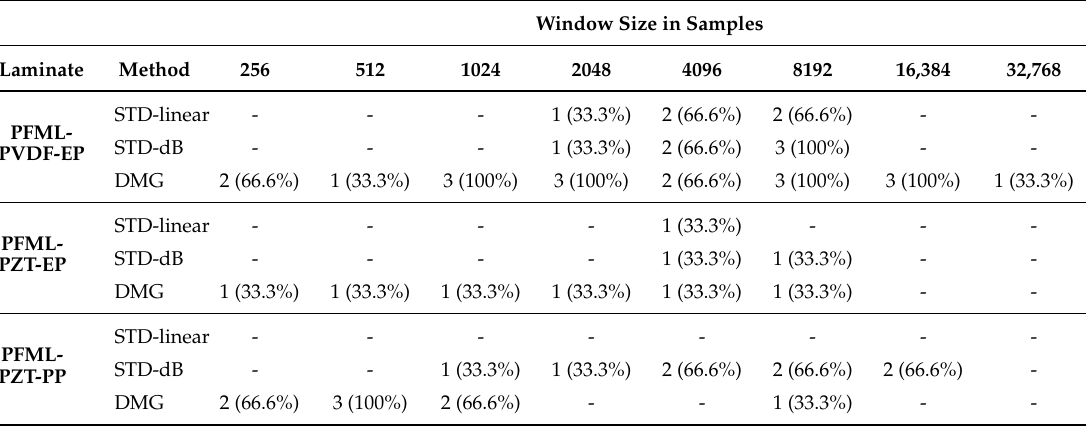
Table 3. Analysis results for trend formation by the standard deviation of the SED (STD) and the damage index (DMG) as a function of scaling and measurement window size for the amount of specimens (numbers in brakes show the retaliative quantity of